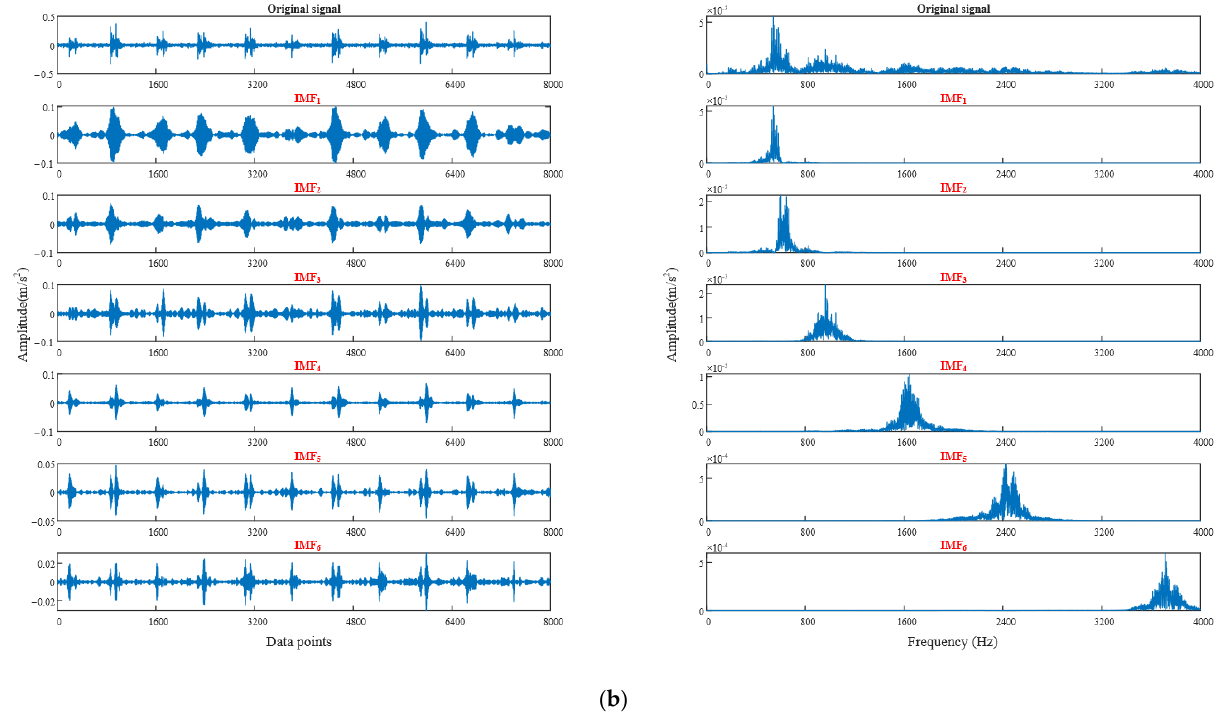
Figure 14. Optimizing VMD to decompose the time-domain waveform and spectrum of vibration signals of different fault types, ( a ) normal, ( b ) inner ring crack.